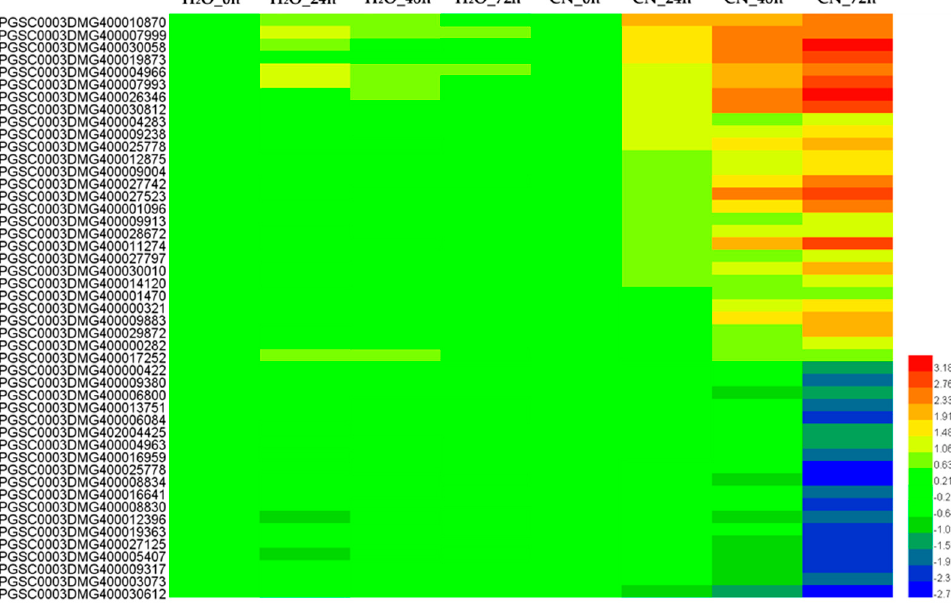
Figure 5. The expression fold-change of genes involved in immune response and HR actions. CN means Phytophthora infestans super isolate CN152. Gene expression levels in CN-0 h samples are given as controls.